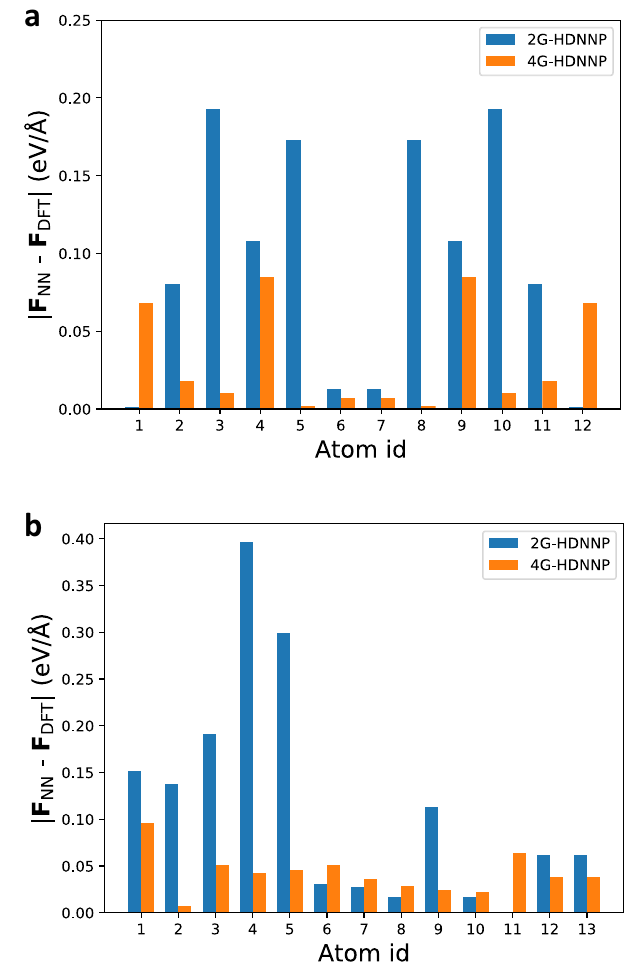
Fig. 4 Force errors of the HDNNPs for the organic molecules. 2G- and 4G-HDNNP forces for the atoms in the DFT-optimized structures of C 10 H 2 and C 10 H þ (indicated in a and b , 3